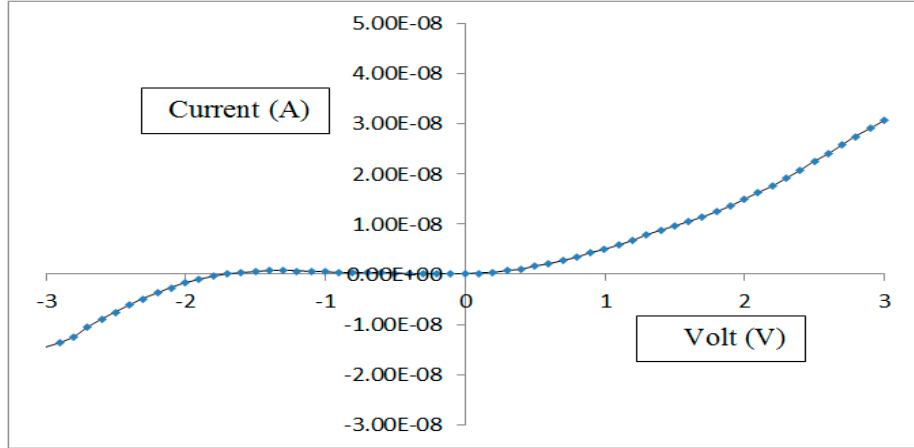
Figure 12. I–V curve of the cross-section of the In 0.1 Ga 0.9 N LED.